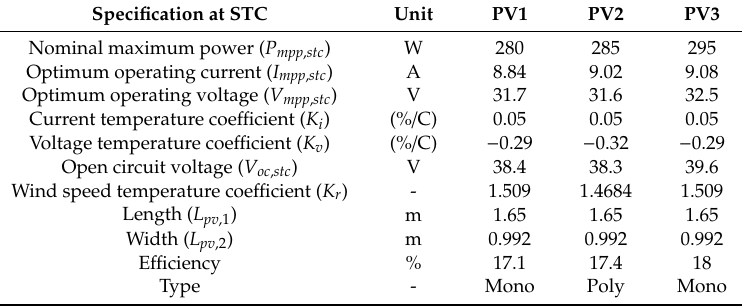
Table 5. Photovoltaic (PV) modules specifications at standard test